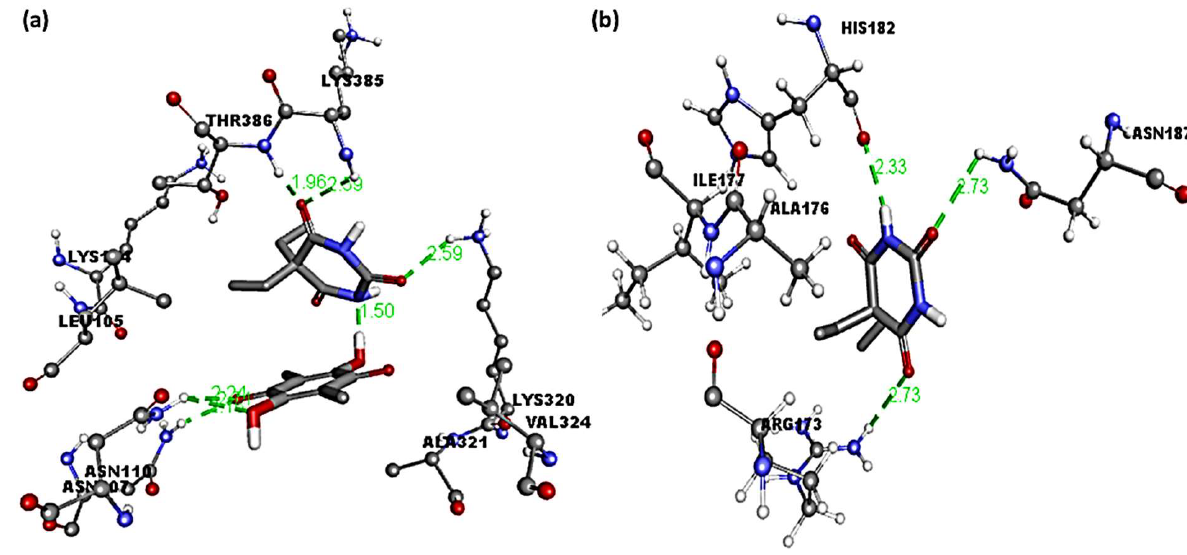
Figure 4. The 3D illustration of a serotonin receptor docked with ( a ) (Bar–CLA) complex and ( b ) Bar